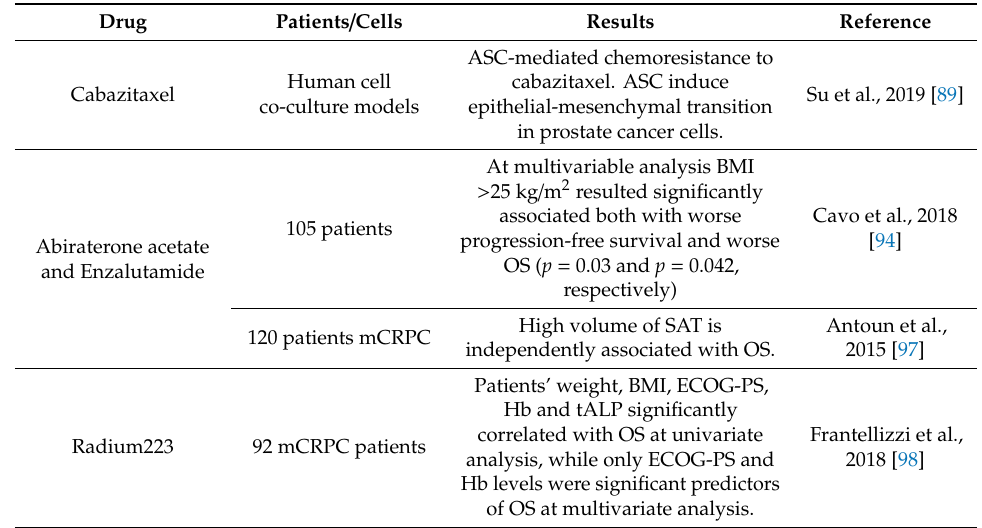
Su et al., 2019 [89] Cavo et al., 2018 [94] Antoun et al., 2015 [97]